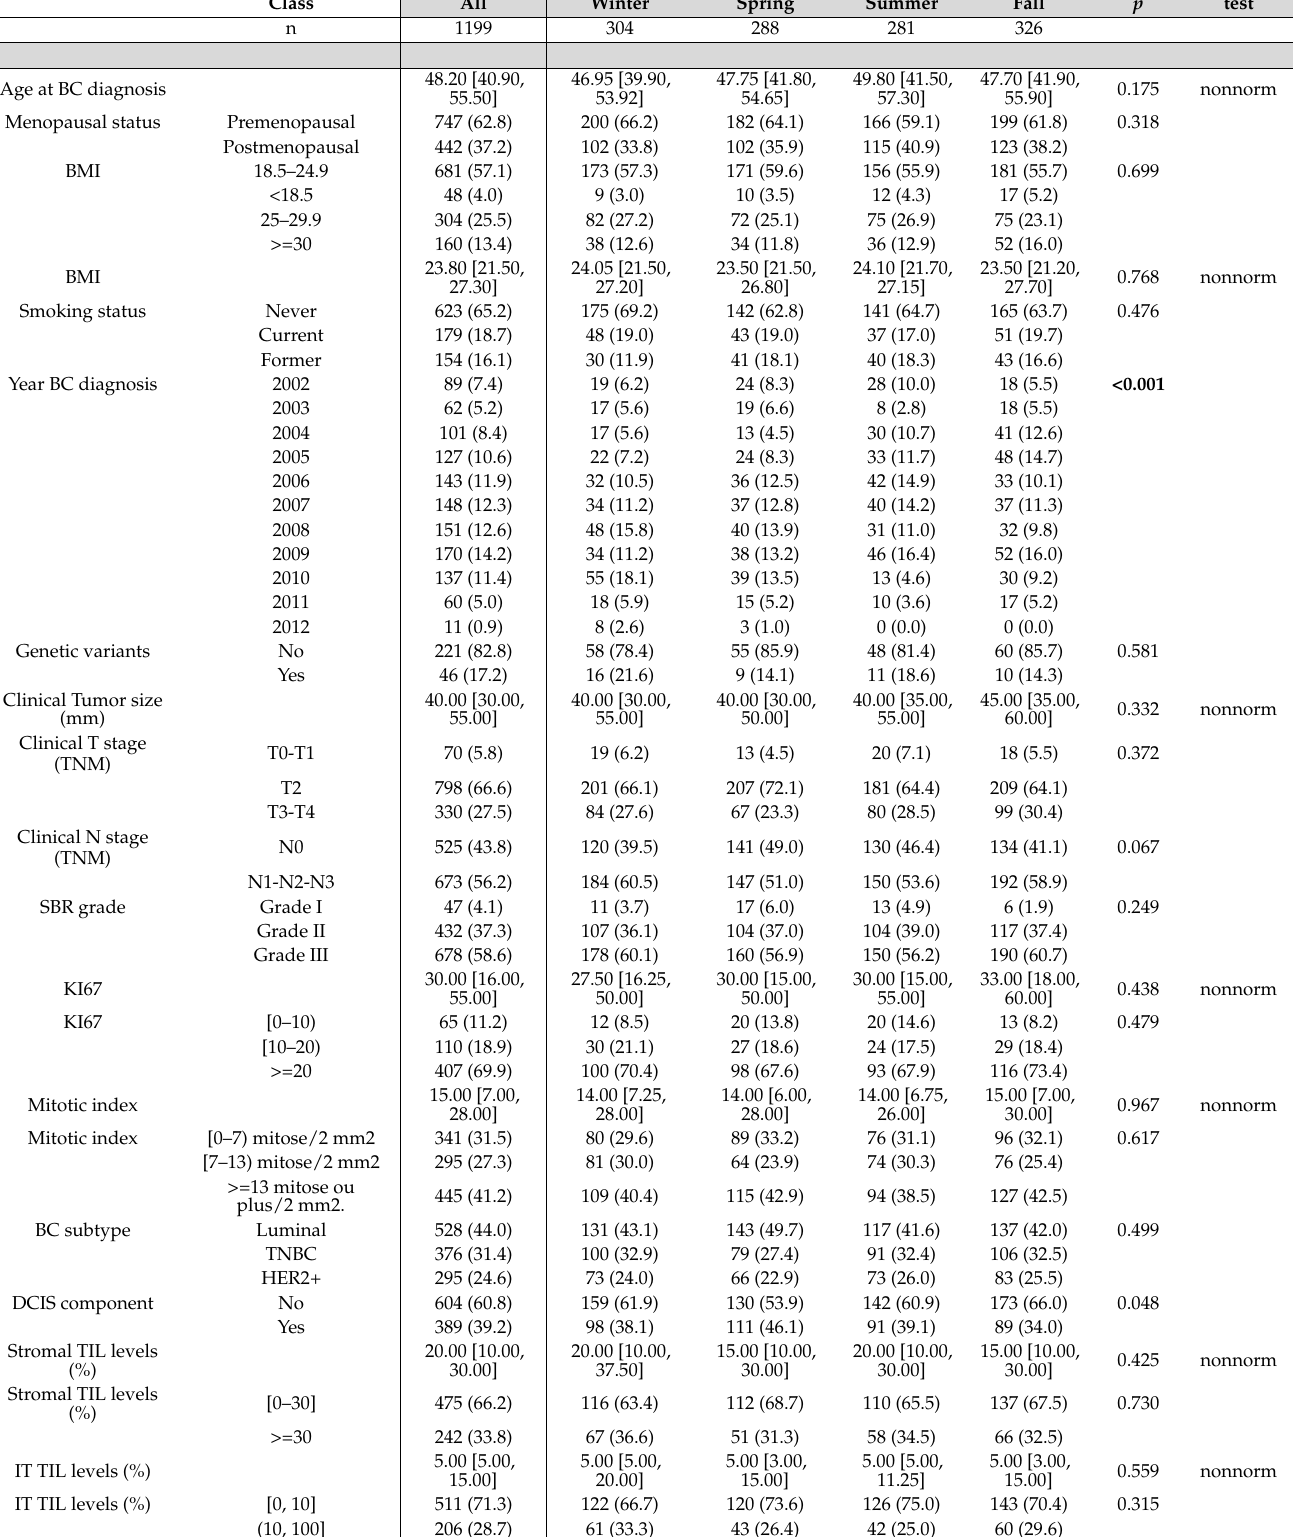
Table 1. Patients and tumor characteristics among the whole population and according to